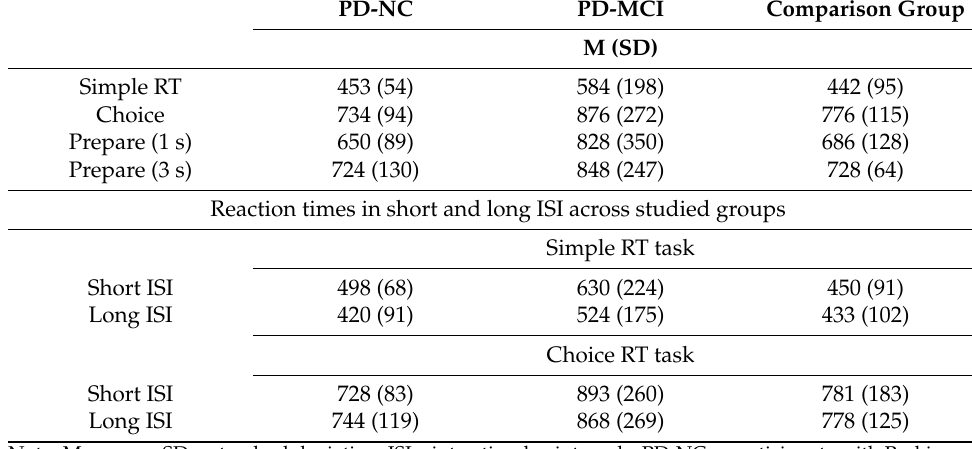
Table 4. Reaction times on all tasks across the studied groups. PD-NC